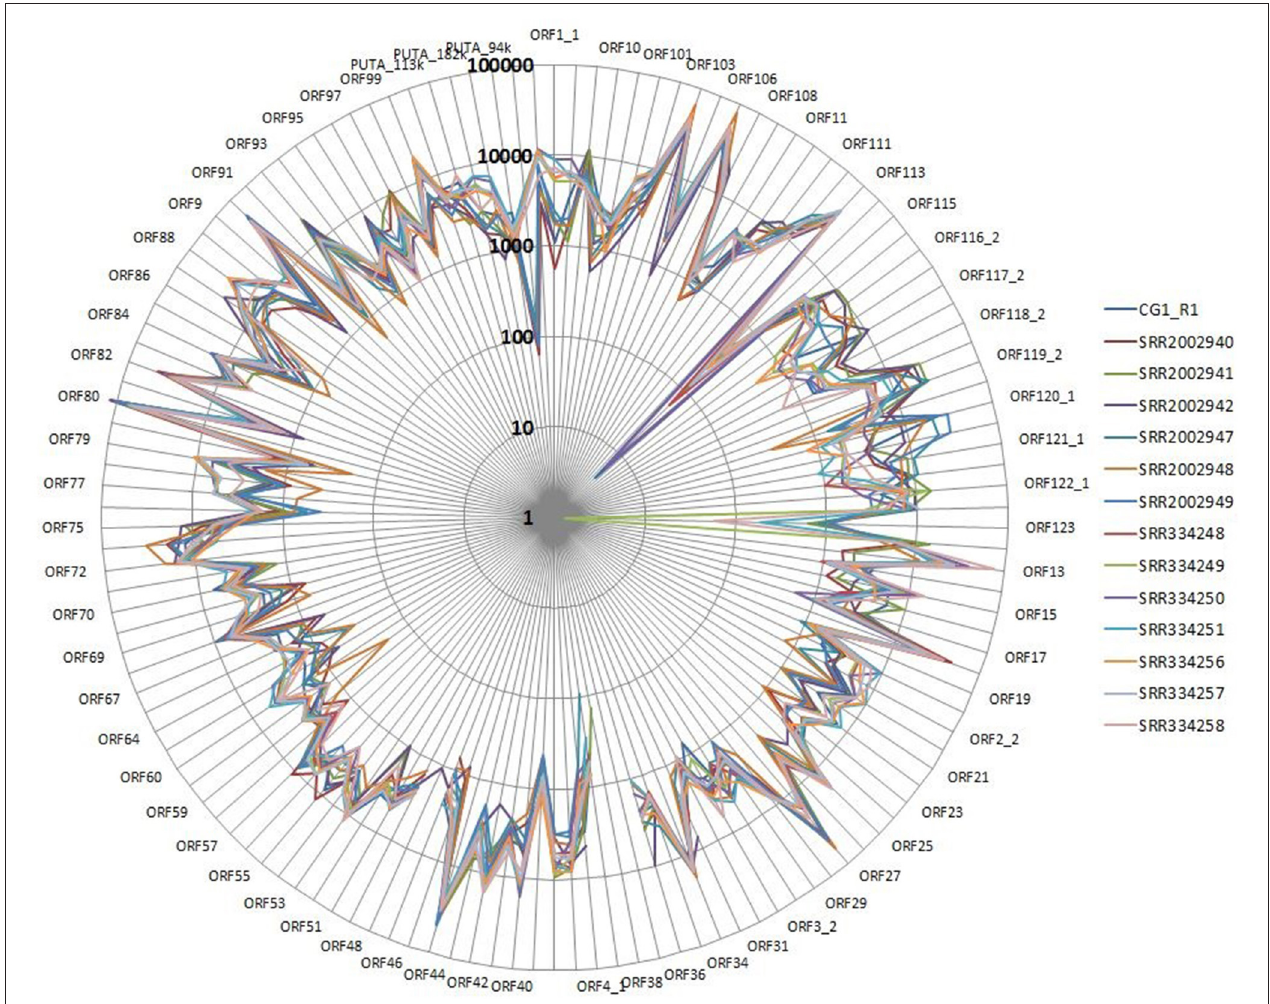
FIGURE 5 | Radar graph depicting the viral TPM values in 14 RNA-seq samples selected as “high”. Expression values are reported with a logarithmic scale.